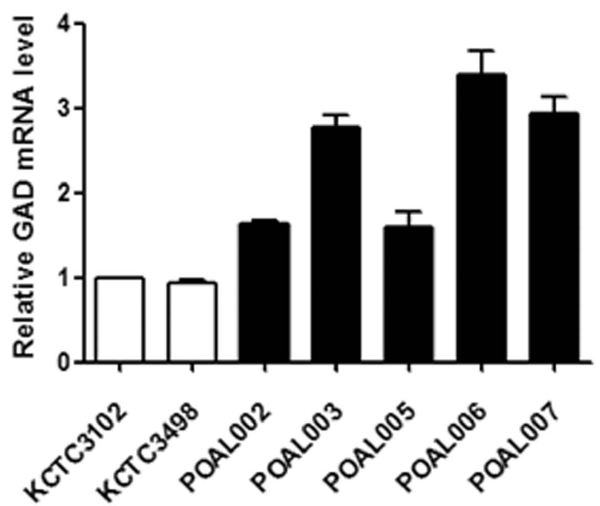
Figure 5. qRT- PCR analysis of GAD expression. Total RNA was isolated from L. brevis, converted to cDNA and analysed by qRT-PCR. KCTC3498 T and KCTC3102 T strains were used as references. Bars represent relative mean intensity. All values are expressed as the means 6 SE, and the statistical significance was set at P , 0.05.